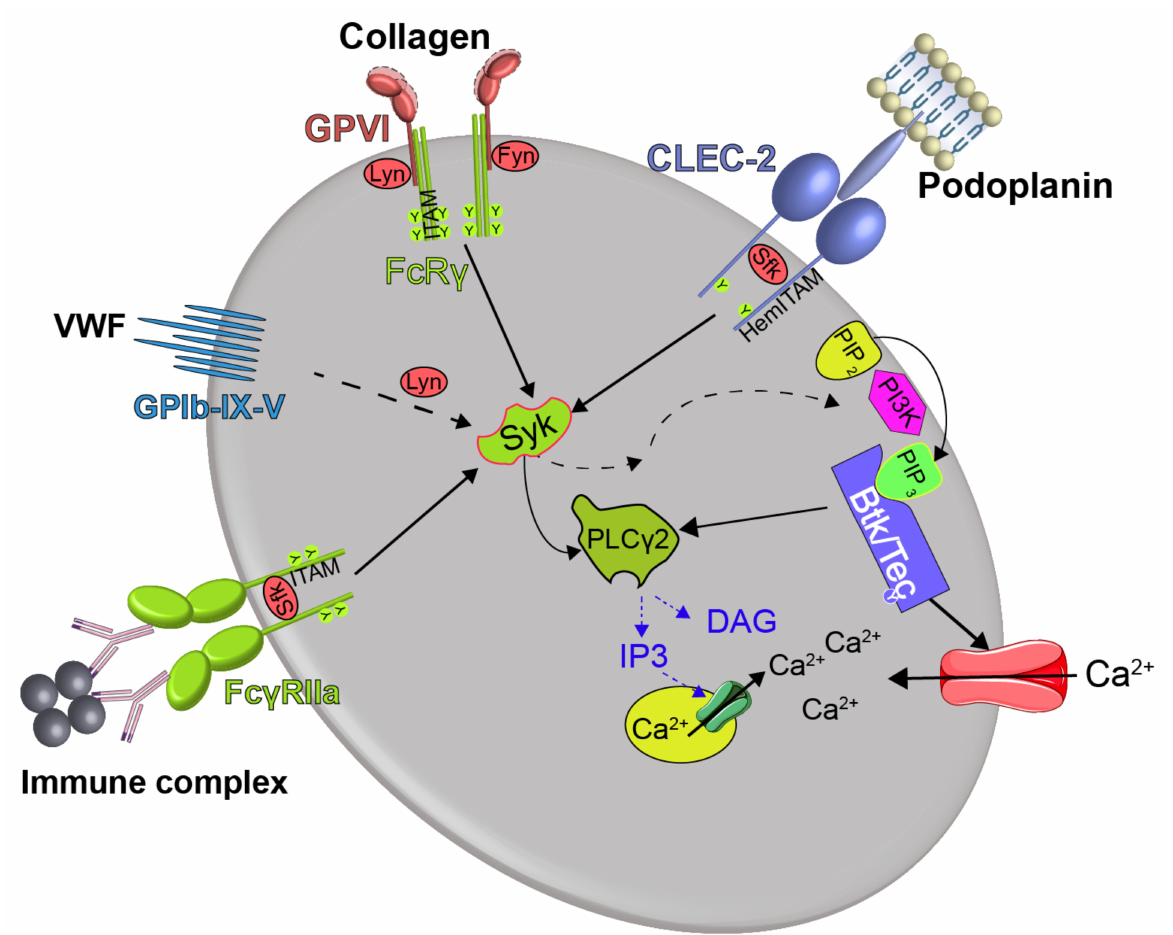
Figure 2. Btk is activated by platelet glycoprotein receptors and transmits signals to increase cytosolic calcium . The signaling pathways of platelet glycoprotein receptors that are coupled to Btk are depicted. Solid arrows indicate direct interaction, dashed arrows indicate indirect activation. The homologous kinase Tec is activated through the same pathways but plays a functional role only after GPVI activation. For details see text. CLEC-2, C-type lectin domain family 2; DAG, 1,2-diacylglycerol; Fc γ RIIa, Fc fragment of IgG low affinity IIa receptor; FcR γ , Fc receptor gamma-chain; GPVI, glycoprotein VI; GPIb-V-IX, glycoproteins Ib,V,IX; hemITAM, single-copy tyrosine-based activation motif; IP3, inositol 1,4,5 triphosphate; ITAM, immunoreceptor tyrosine-based activation motif; PLC2 γ 2, phospholipase C γ 2; PI3-kinase, phosphatidylinositol 3-kinase; PIP2, phosphatidylinositol(4,5)-bisphosphate; PIP3, phosphatidylinositol(3,4,5)-trisphosphate; SFK, Src family kinases; Syk, spleen tyrosine kinase, VWF, von Willebrand